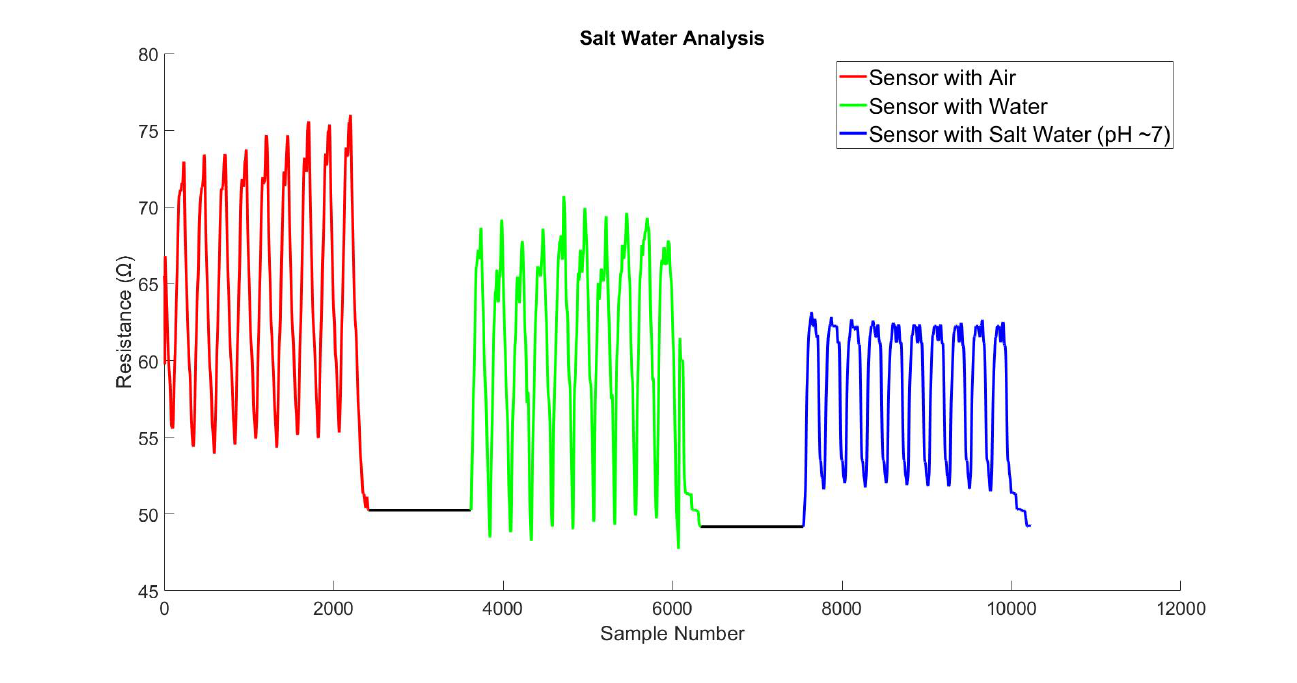
Figure A7. Salt-fog test data of (sensor-2).